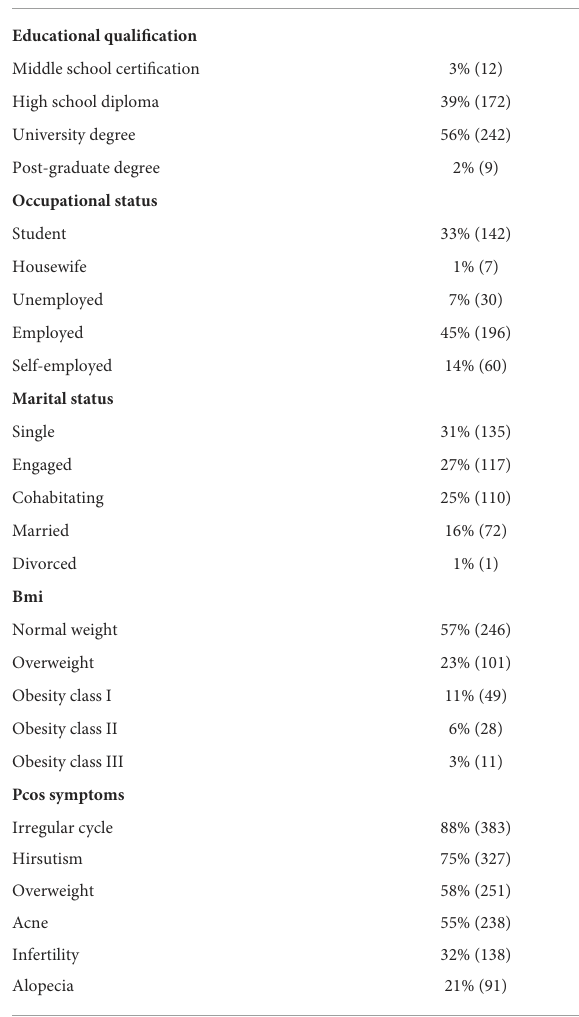
TABLE 1 Demographics and sample